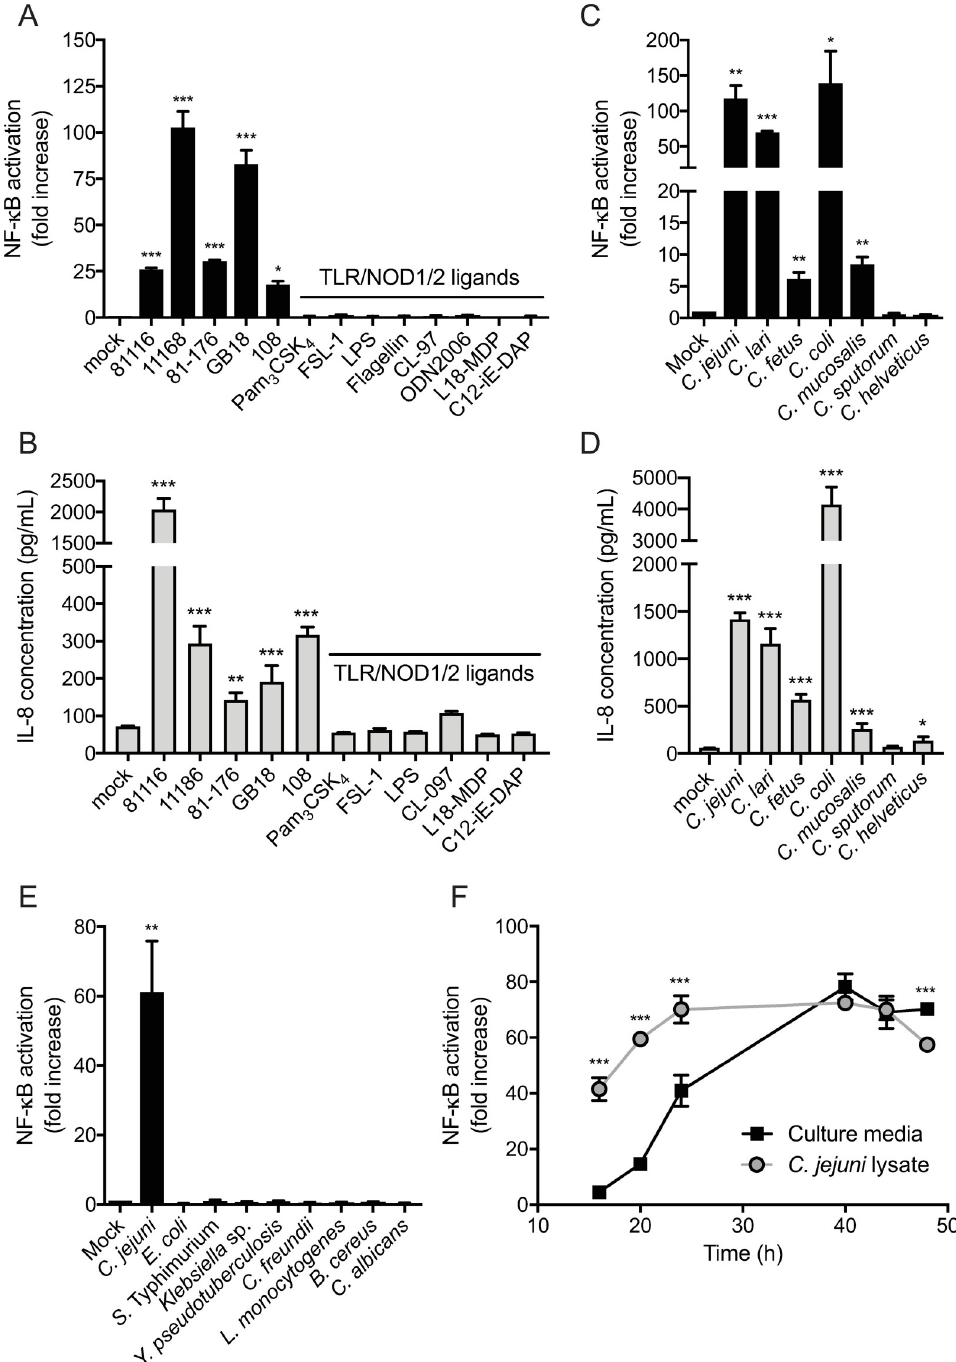
Fig 1. Campylobacter releases a novel activator of NF- κ B into the culture supernatant. (A, B) HeLa 57A cells were stimulated with sterile conditioned culture supernatant of five different C . jejuni strains or with the TLR/NOD1/2 ligands Pam 3 CSK 4 , FSL-1, Poly(I:C), LPS, flagellin, CL-97, ODN2006, L18-MDP or C12-iE-DAP. (C-E) Sterile conditioned culture supernatants of C . jejuni , C . lari , C . fetus , C . coli , C . mucosalis , C . sputorum and C . helveticus , E . coli , S . Typhimurium, Klebsiell a sp., Y . pseudotuberculosis , C . freundii , L . monocytogenes , B . cereus or C . albicans were used to stimulate HeLa 57A cells for 5 h (NF- κ B) or 18 h (IL-8). (F) HeLa 57A cells were stimulated with sterile C . jejuni strain 81116-conditioned culture supernatant or C . jejuni strain 81116 cells disrupted via sonification at timepoints 16, 20, 24, 40, 44 and 48 h after the start of culturing. Asterisks refer to statistically significant differences between NF- κ B